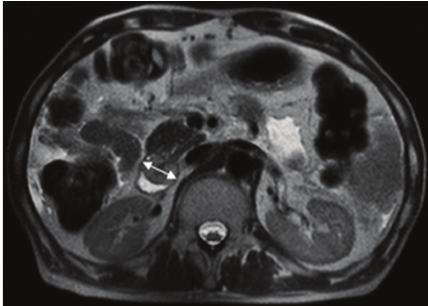
Figure 3: Abdominal magnetic resonance imaging shows a pedun- culated mass at the level of ampulla with mild enhancement (double